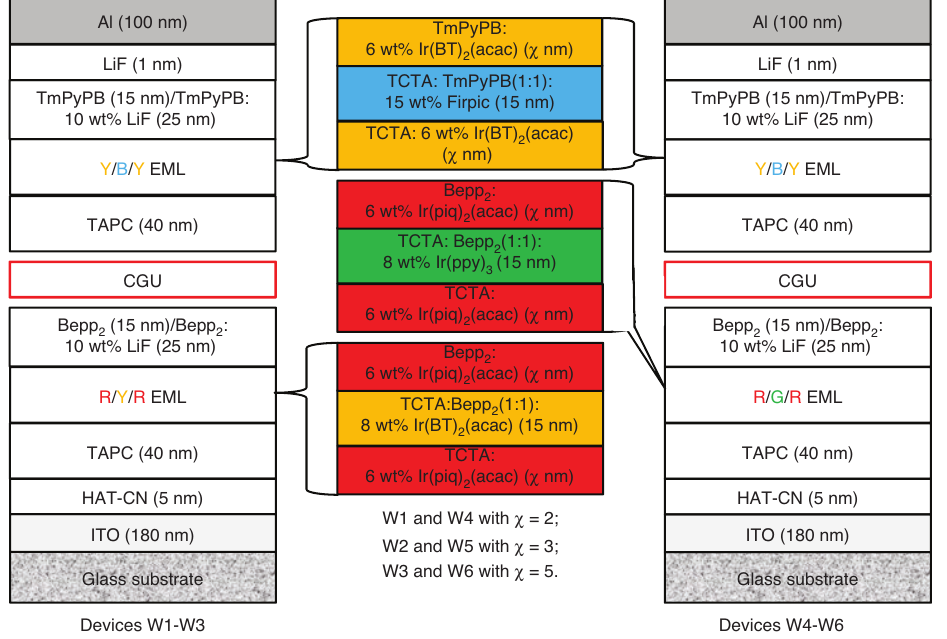
Figure 6: The device structure diagram of all tandem three-color (W1–W3) and four-color (W4–W6) WOLEDs involved in this work, where the CGU is LiF(1 nm)/Al(3 nm)/HAT-CN(10 nm)/HAT-CN:TAPC(2:1, 80